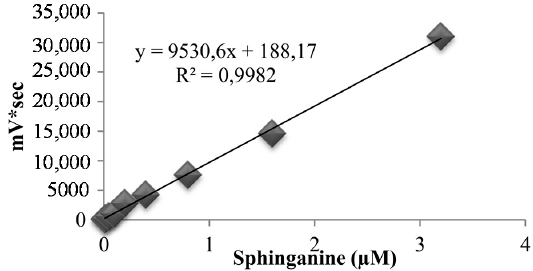
Figure 4. Calibration curve of sphinganine.